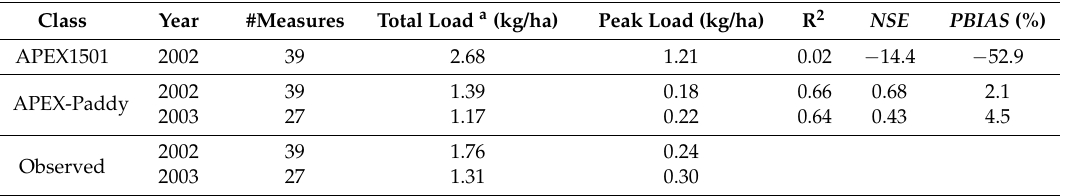
Table 5. Dissolved nitrogen loads in paddy discharge (QN) estimated by Paddy module compared with the SCS-CN method at the Icheon site.